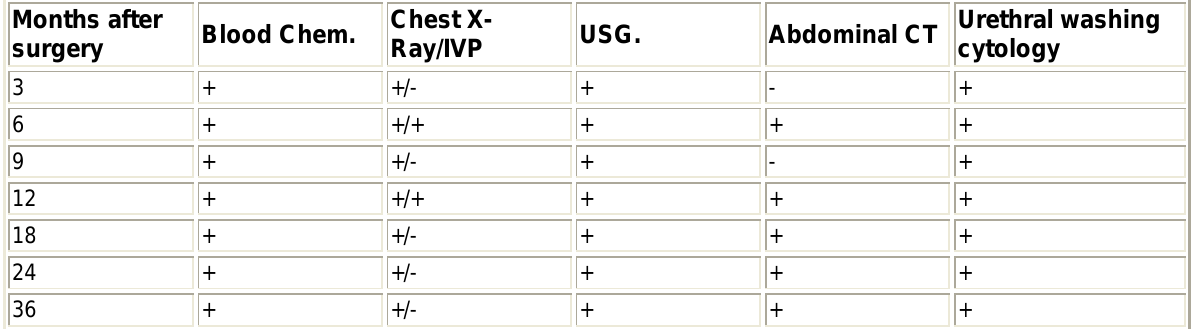
Follow-up schedule of the patients. Blood chemistry included urea, creatine, Na, K, Cl, Ca,